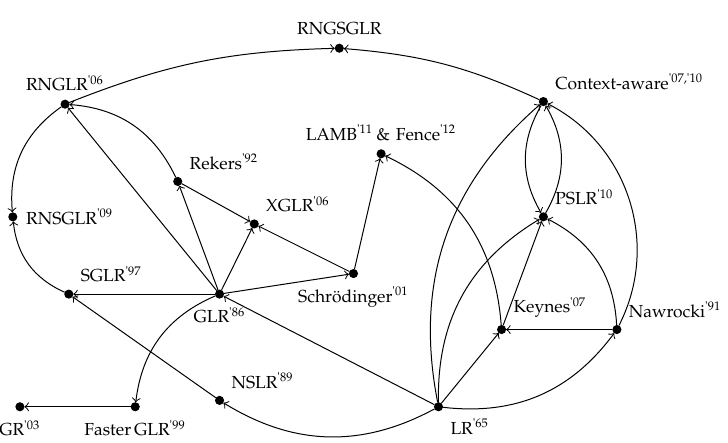
Figure 27. The dependency graph of the related work. Each is accompanied with the year of